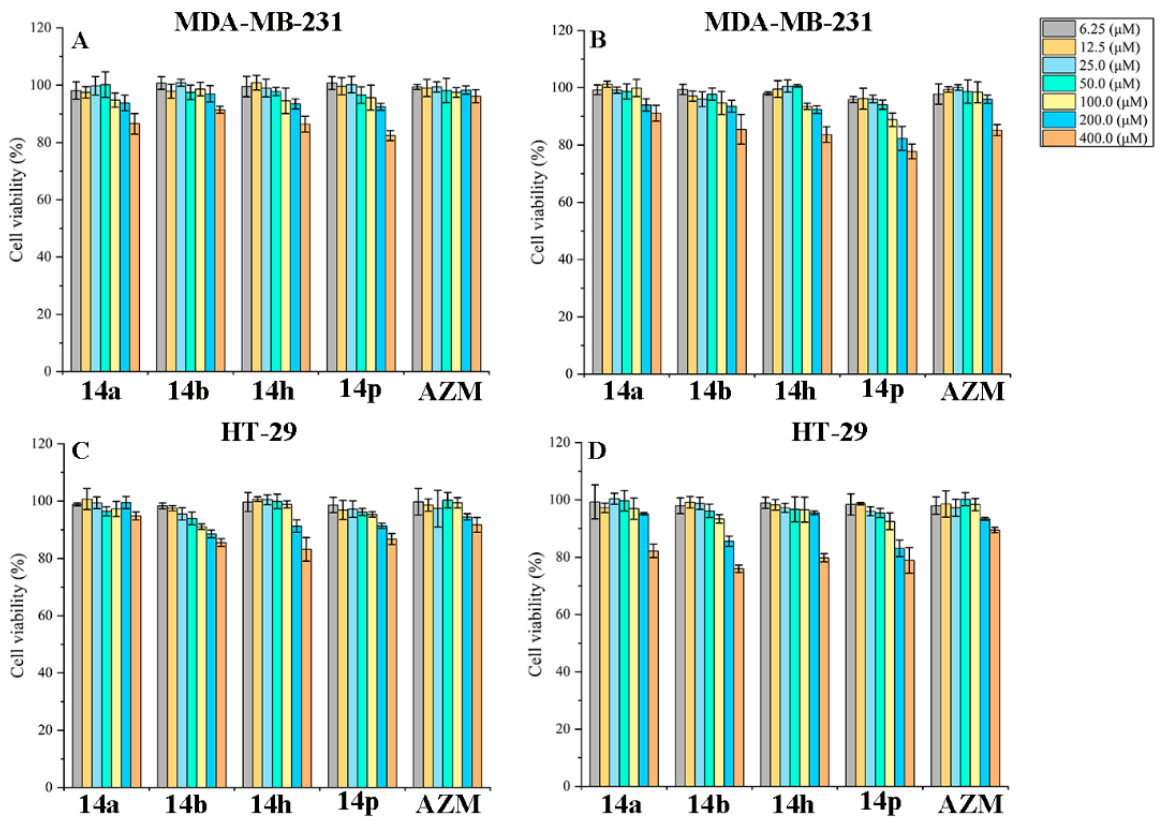
Figure 5. Effects of compounds 14a , 14b , 14h , 14p , and AZM on the cell viability of HT-29 and MDA-MB-231 under normoxic ( A , C ) and hypoxic ( B , D ) conditions.